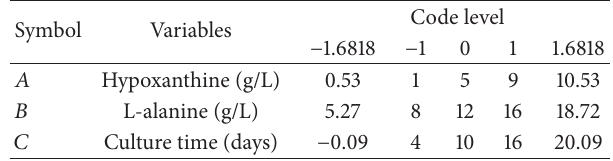
Table 4: Factors and levels of central composite design for amino acid, nucleoside analogue, and